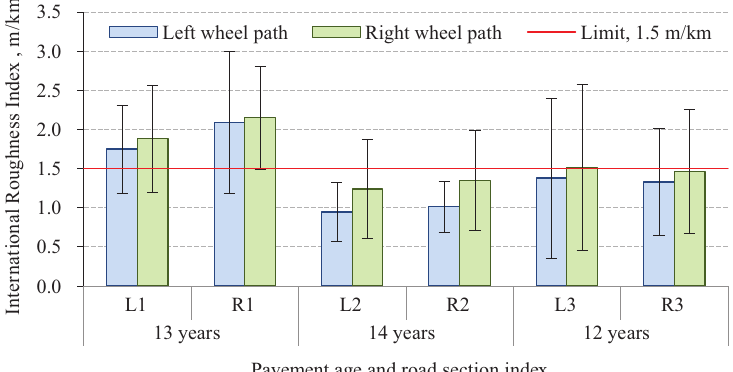
Figure 4. Mean of International Roughness Index by pavement age